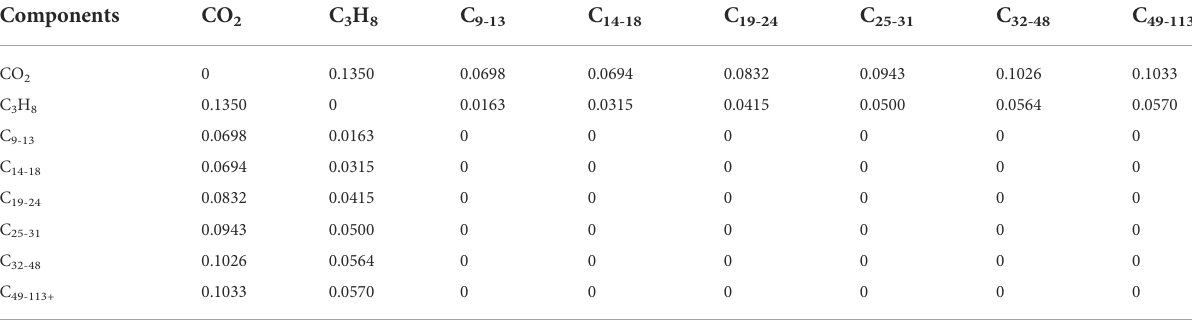
TABLE 7 Binary interaction parameters for fl uid components. Components